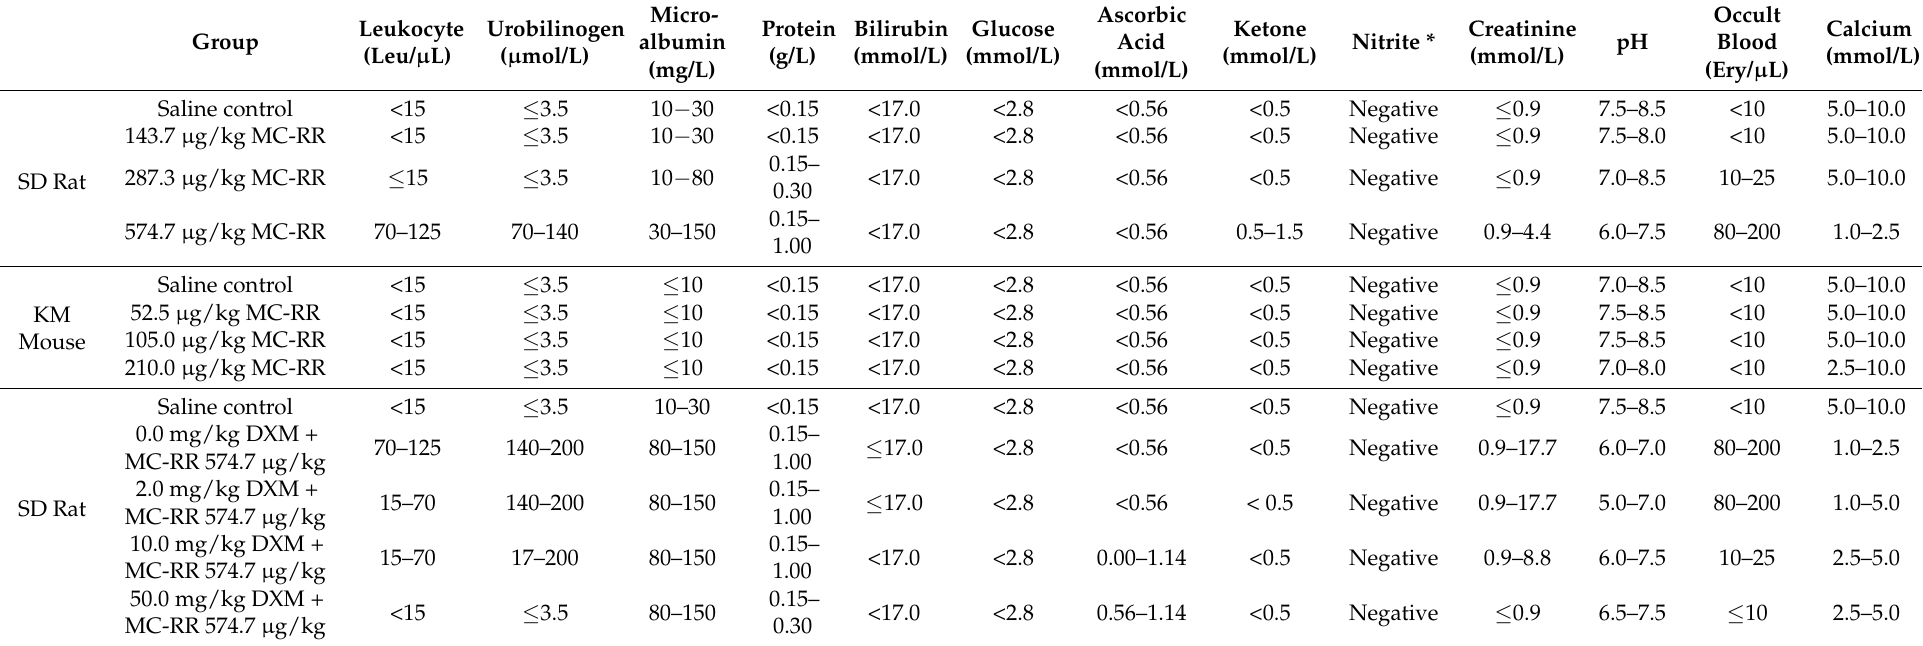
Table 2. Urinalysis of SD rats and KM mice treated with MC-RR in single dose experiment detected by the semiquantitative colorimetric reagent strip.